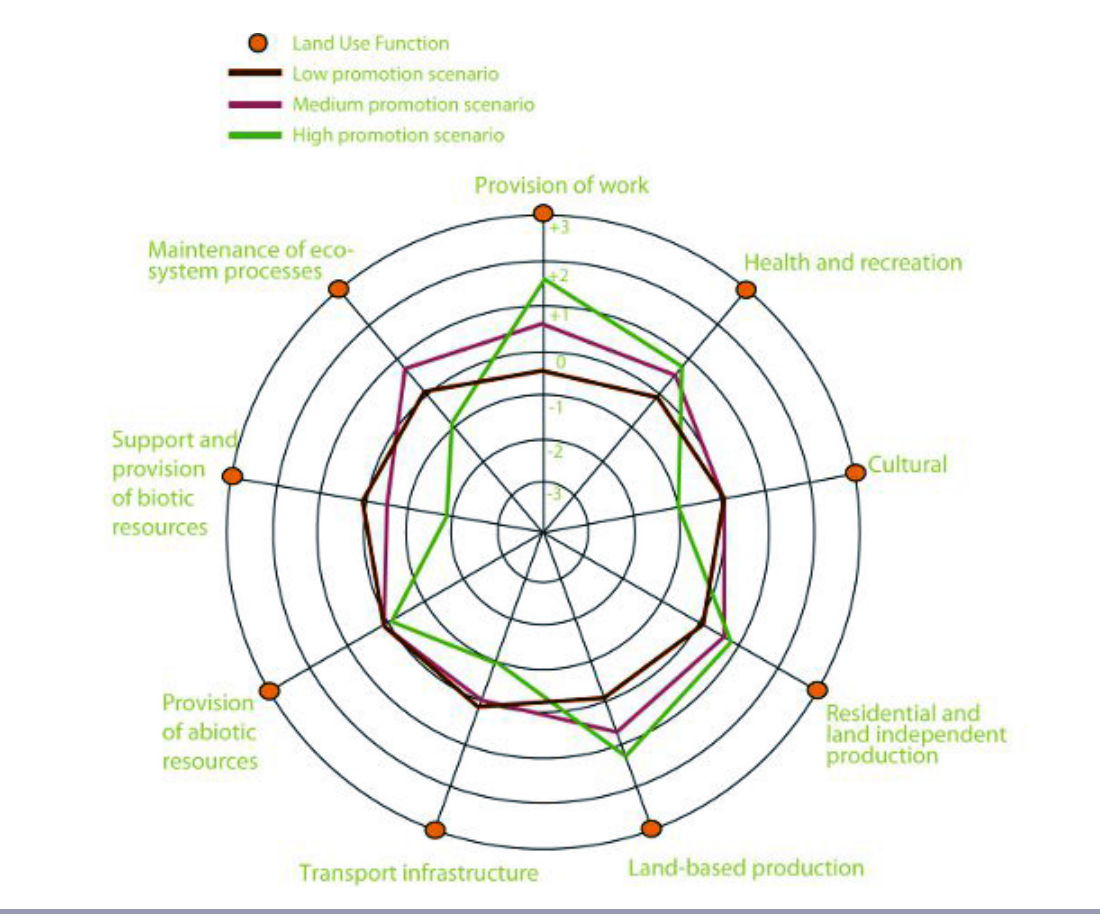
Fig. 9 . Silesia, Poland, bioenergy promotion policy scenario: impact on land-use functions. The diagram shows impact assessment scores for land-use functions under three policy scenarios in 2025, as derived through a stakeholder participatory